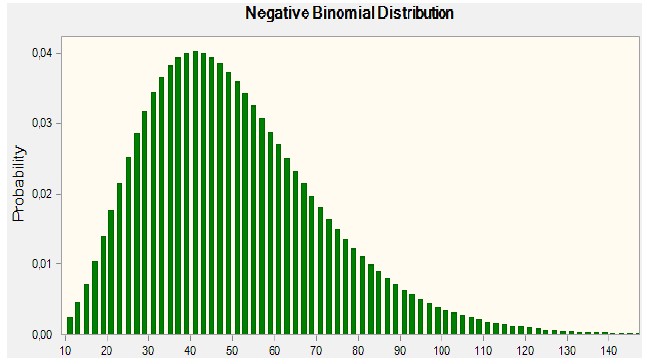
Figure 8. Probability distribution of rent prices for a standard double-room in the region of Poprad–Vysoké Tatry. Table 8. Descriptive statistics of the probability distribution of the rent prices for a standard double- room in the region of Poprad–Vysok é